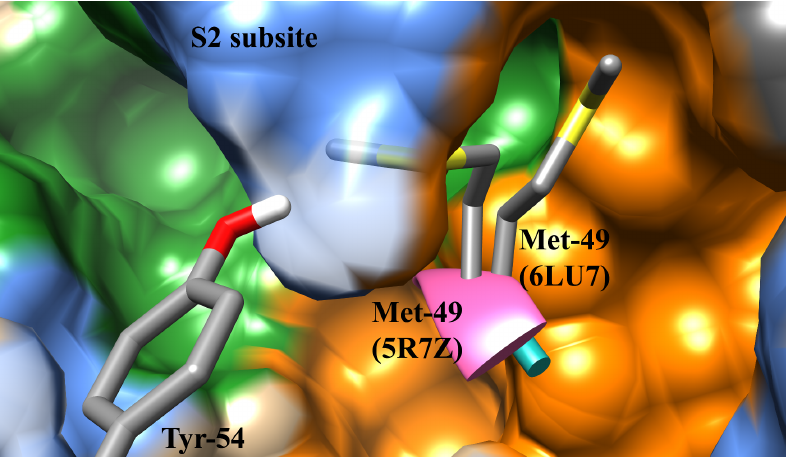
Figure 2. Impact of Met-49 in the length of S2 subsite. The orientation of the residue Met-49 in the 5R7Z receptor decreases the length of the S2